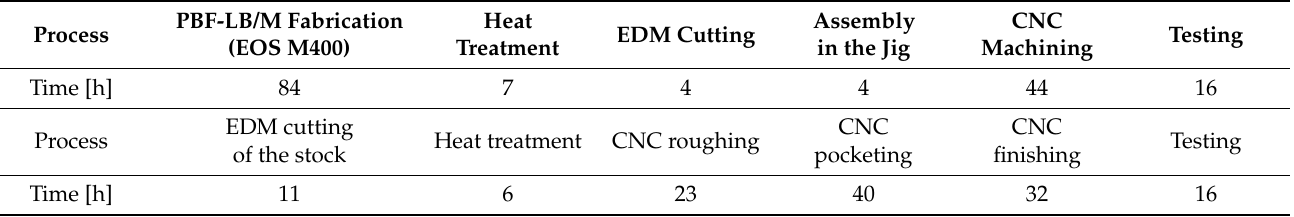
Table 7. Processing time for the various realization steps.